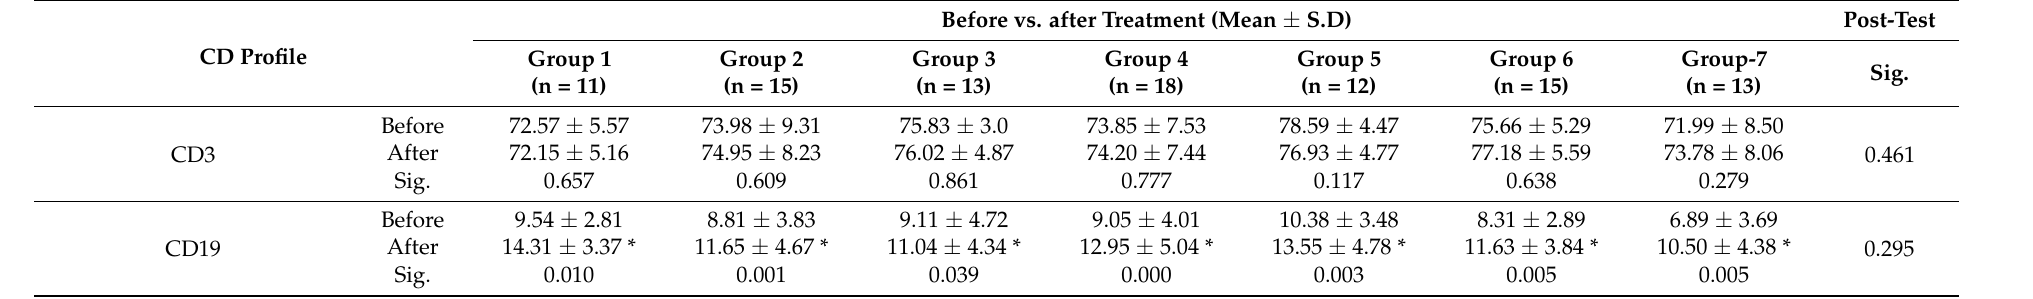
Table 4. Comparisons of CD